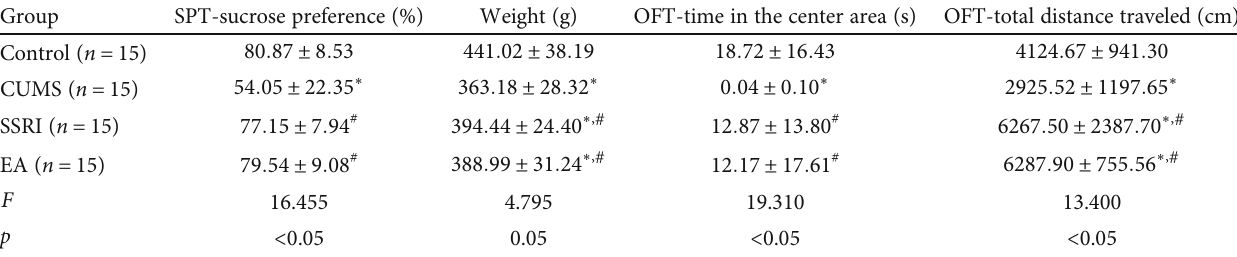
Table 2: Comparison of SPT, weight, and OFT among 4 groups ( mean ± SD ).